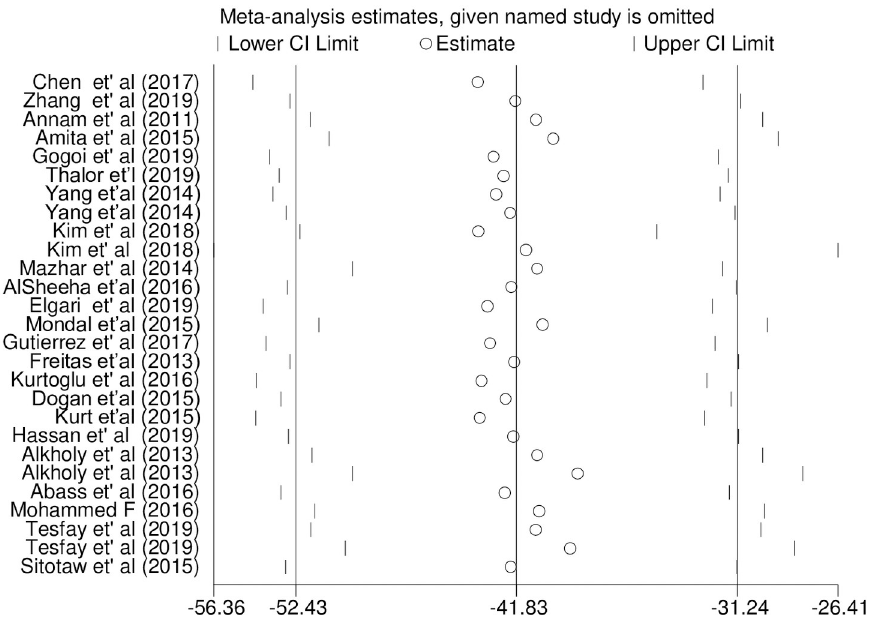
Fig 12. Sensitivity statistics of WMD analysis of PC between PE and NT groups.